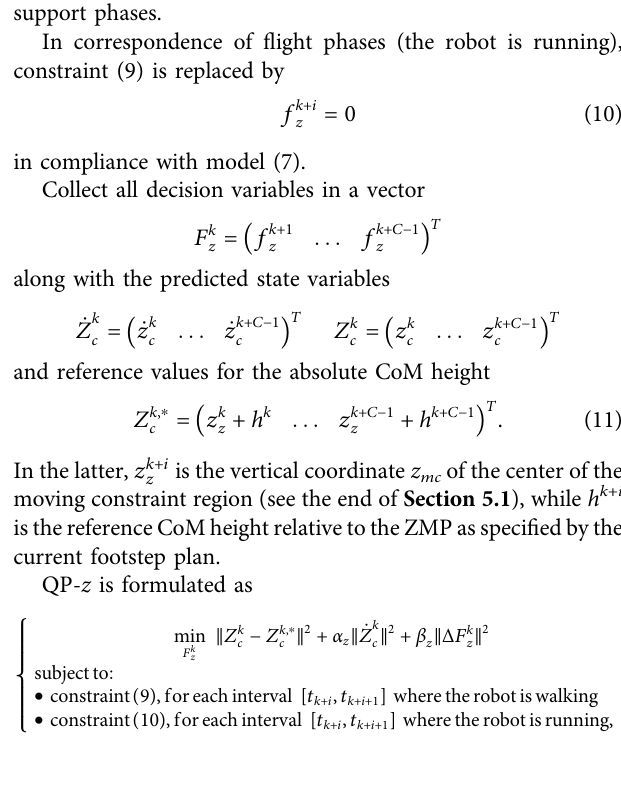
Frontiers in Robotics and AI |